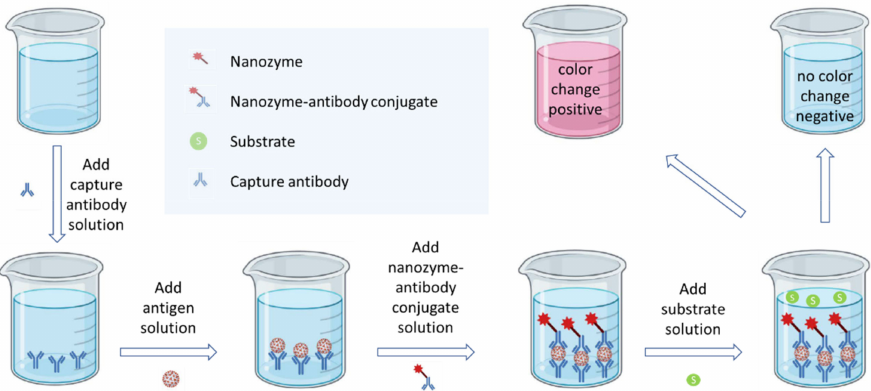
Figure 3. Graphical illustration of generic microbial nanozyme-linked immunoassay